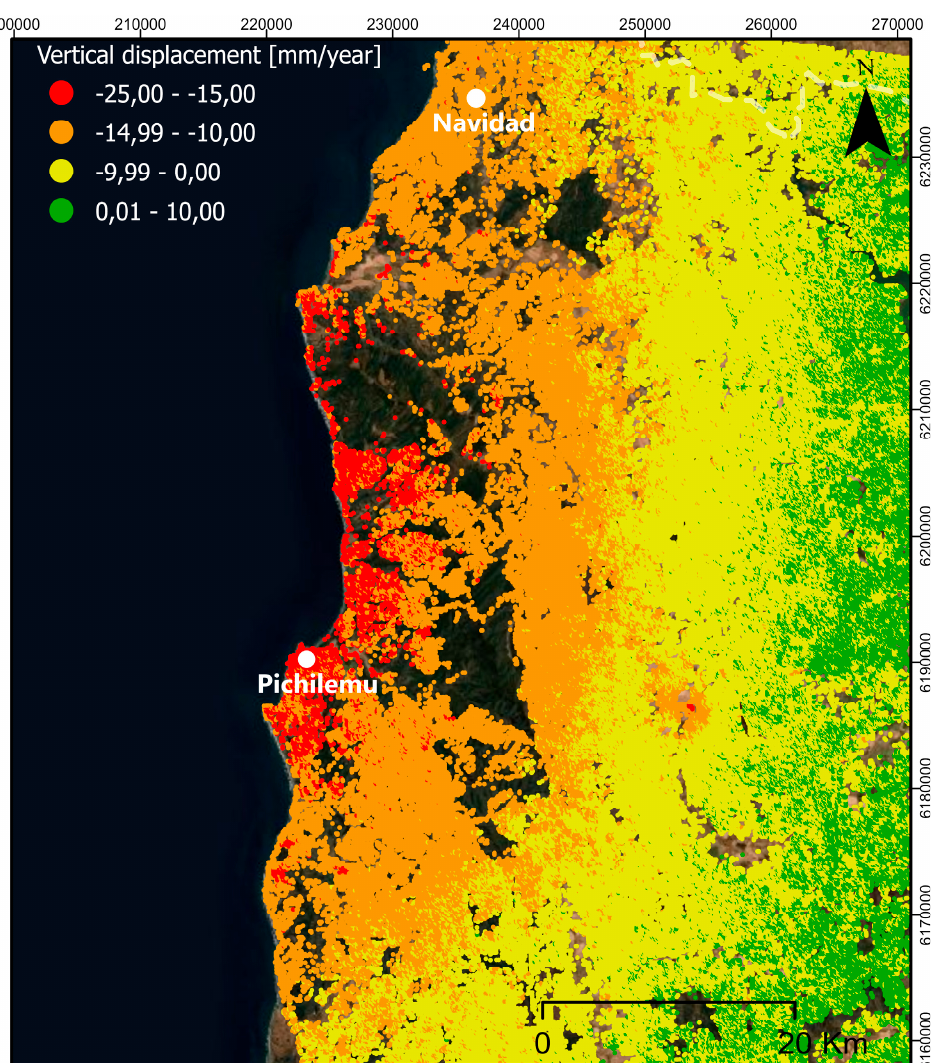
Figure 8. Vertical displacement component estimation map (mm/year) for subsidence area.